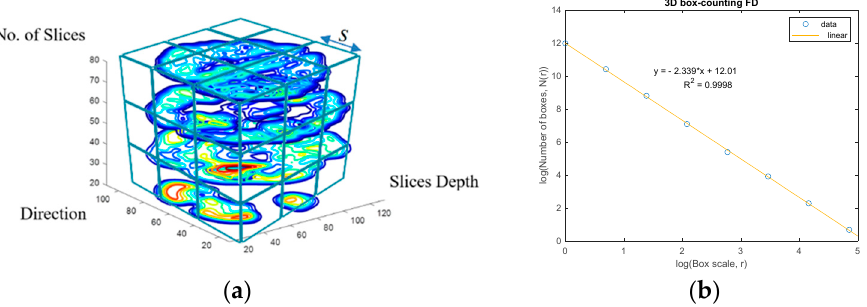
Figure 2. Illustration of 3D box − counting fractal dimension applied on MRI images. ( a ) Step 1: Count the number of boxes N with scale s that cover the MRI voxels and ( b ) Step 2: Estimate FD based on the slope of the least − squares − fit of the log − log relationship.